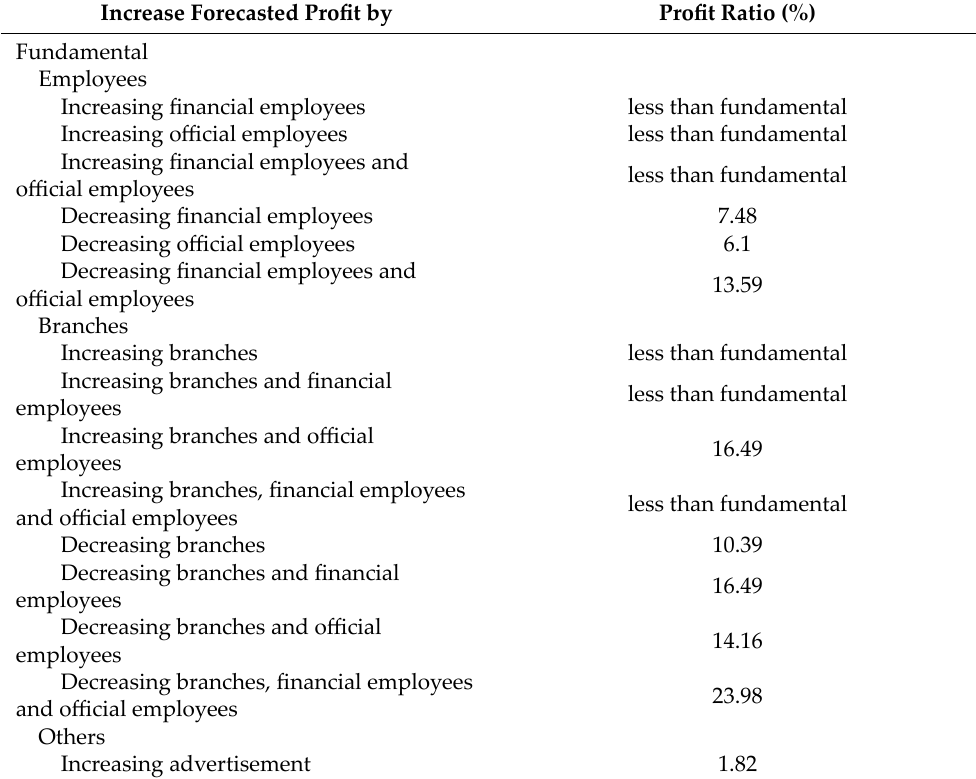
Table 10. Result of model